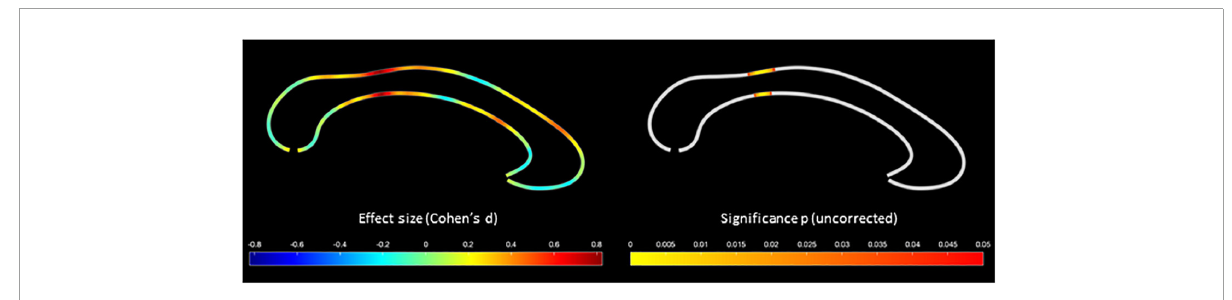
FIGURE1 Greater callosal thickness in the ayahuasca group compared to the control group. The color bar encodes the effect size (Cohen’s d) on the left , and the uncorrected significance (p) on the right .